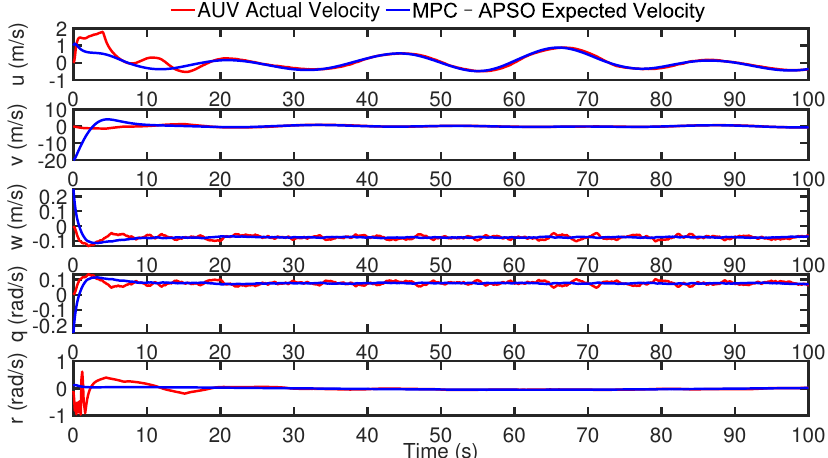
Figure 28. Velocity tracking for the AUV with random disturbance for Case